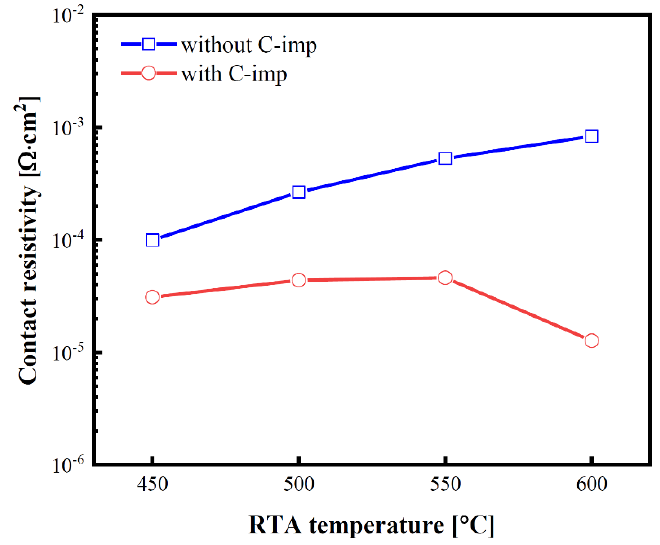
Figure 4. ρ c of the Ti/Ge contacts without (blue curve) and with (red curve) C-imp as a function of RTA temperatures ranging from 450 to 600 °C.